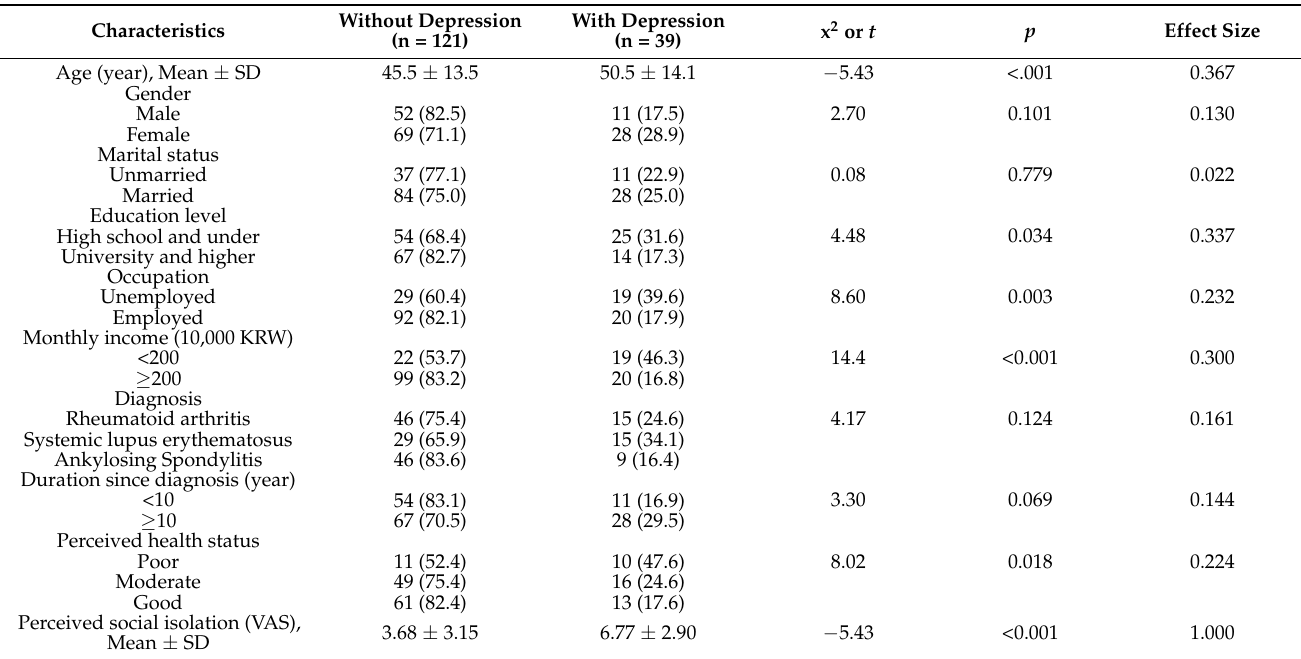
Table 2. Prevalence of PTSD, insomnia, and depression by general characteristics ( N =